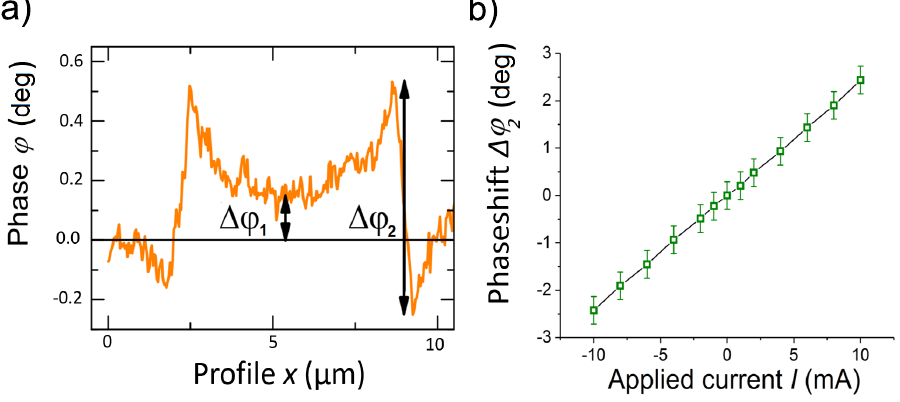
Figure 7. ( a ) Line scan of the phase through the current loop at 3 mA current and the definitions of the phase differences. ( b ) Phase difference ∆ ϕ 2 of the current loop as a function of the applied current at 100 nm lift scan